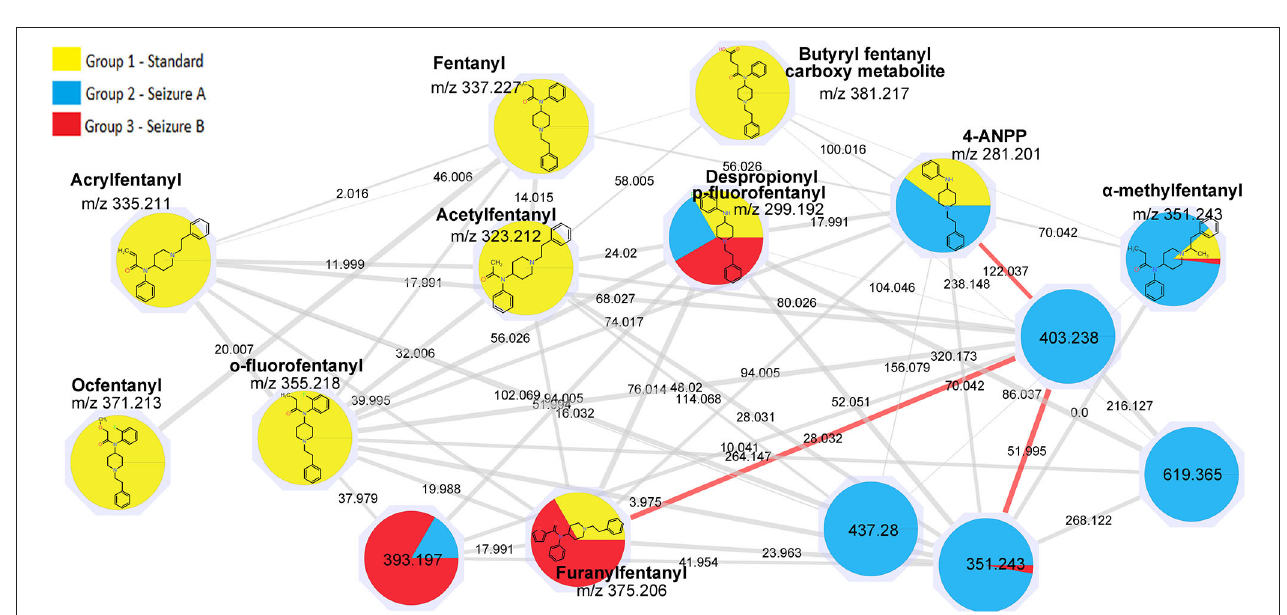
FIGURE 2 | Fentanyl